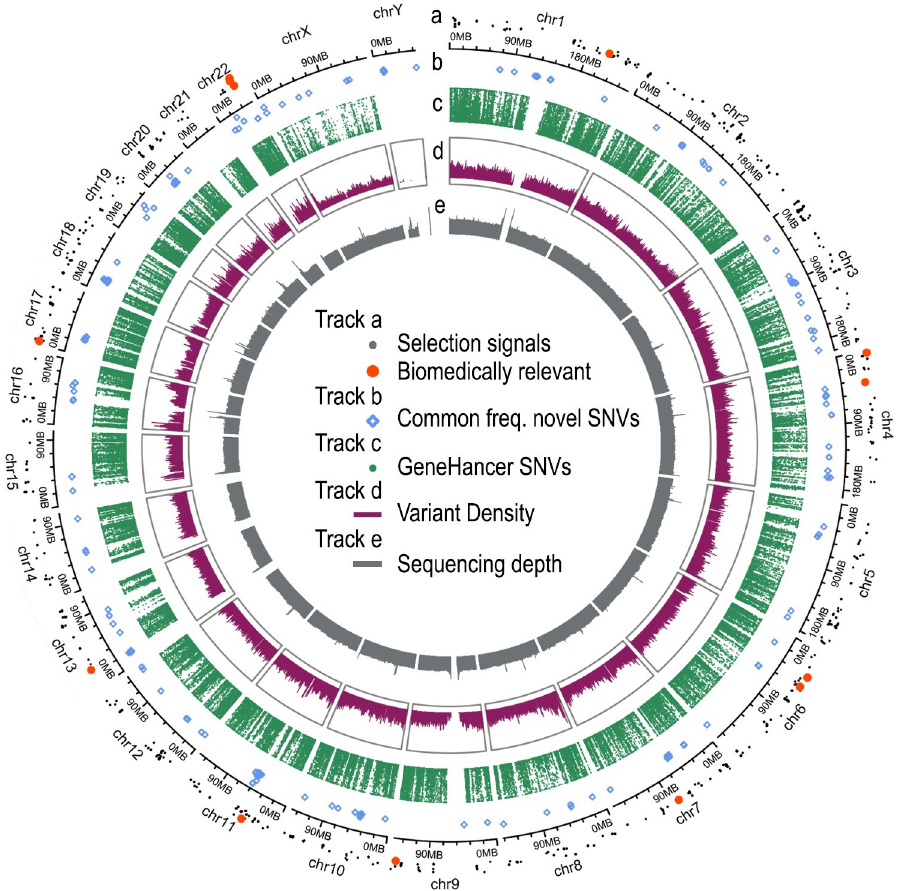
Fig 3. GRCh38 variation overview in NM. (a) SNVs under selection, health related selection signals (matching a GWAS catalog or ClinVar registry) are highlighted in orange. (b) Novel SNVs with allele frequency higher than 5%. (c) SNVs altering enhancer or promoter elements. Height of the dots in a, b and c depicts the allele frequency of the variants. (d) Population-wide variant density. (e) Average NGS genome